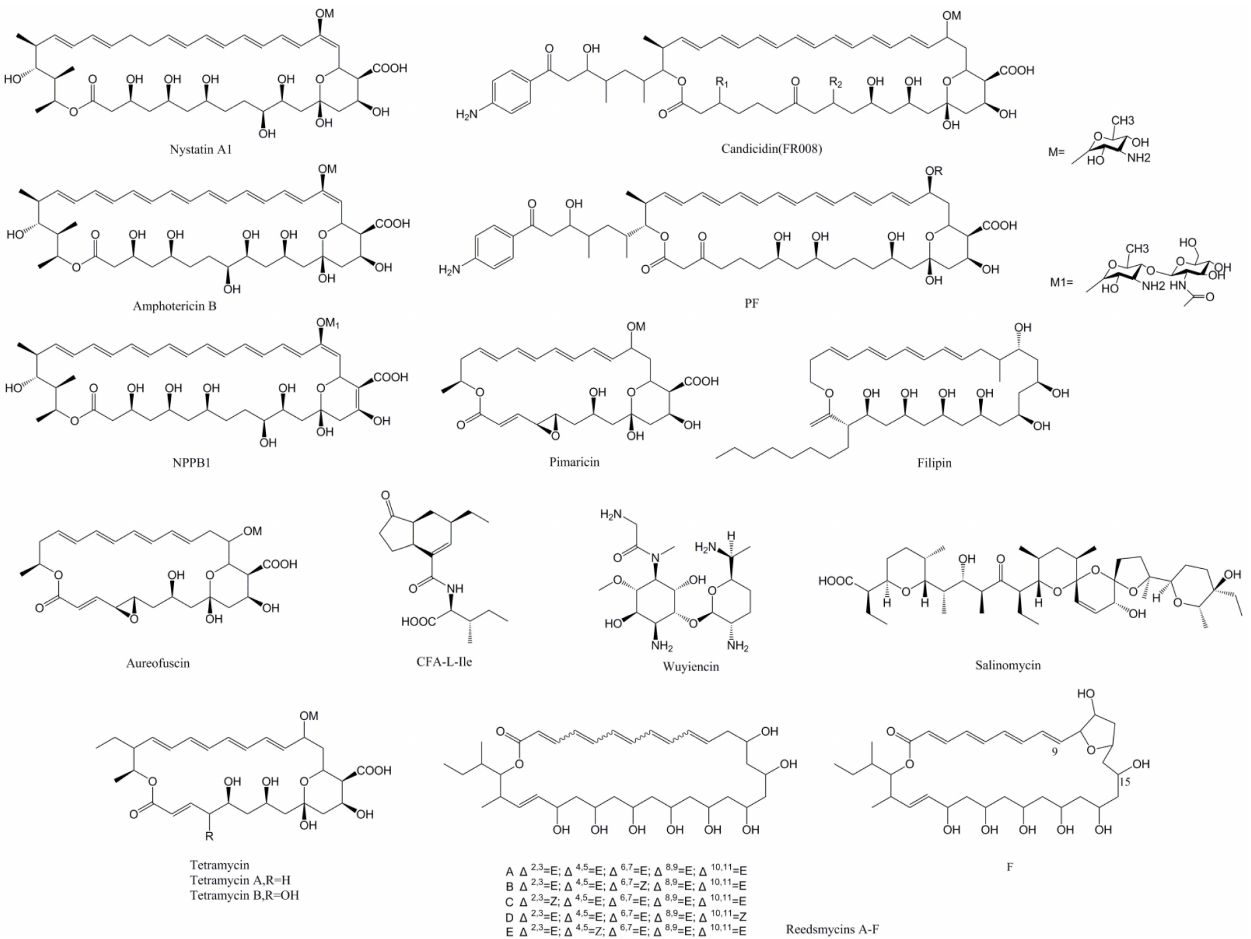
Figure 1. Structures of secondary metabolites regulated by the PAS-LuxR family